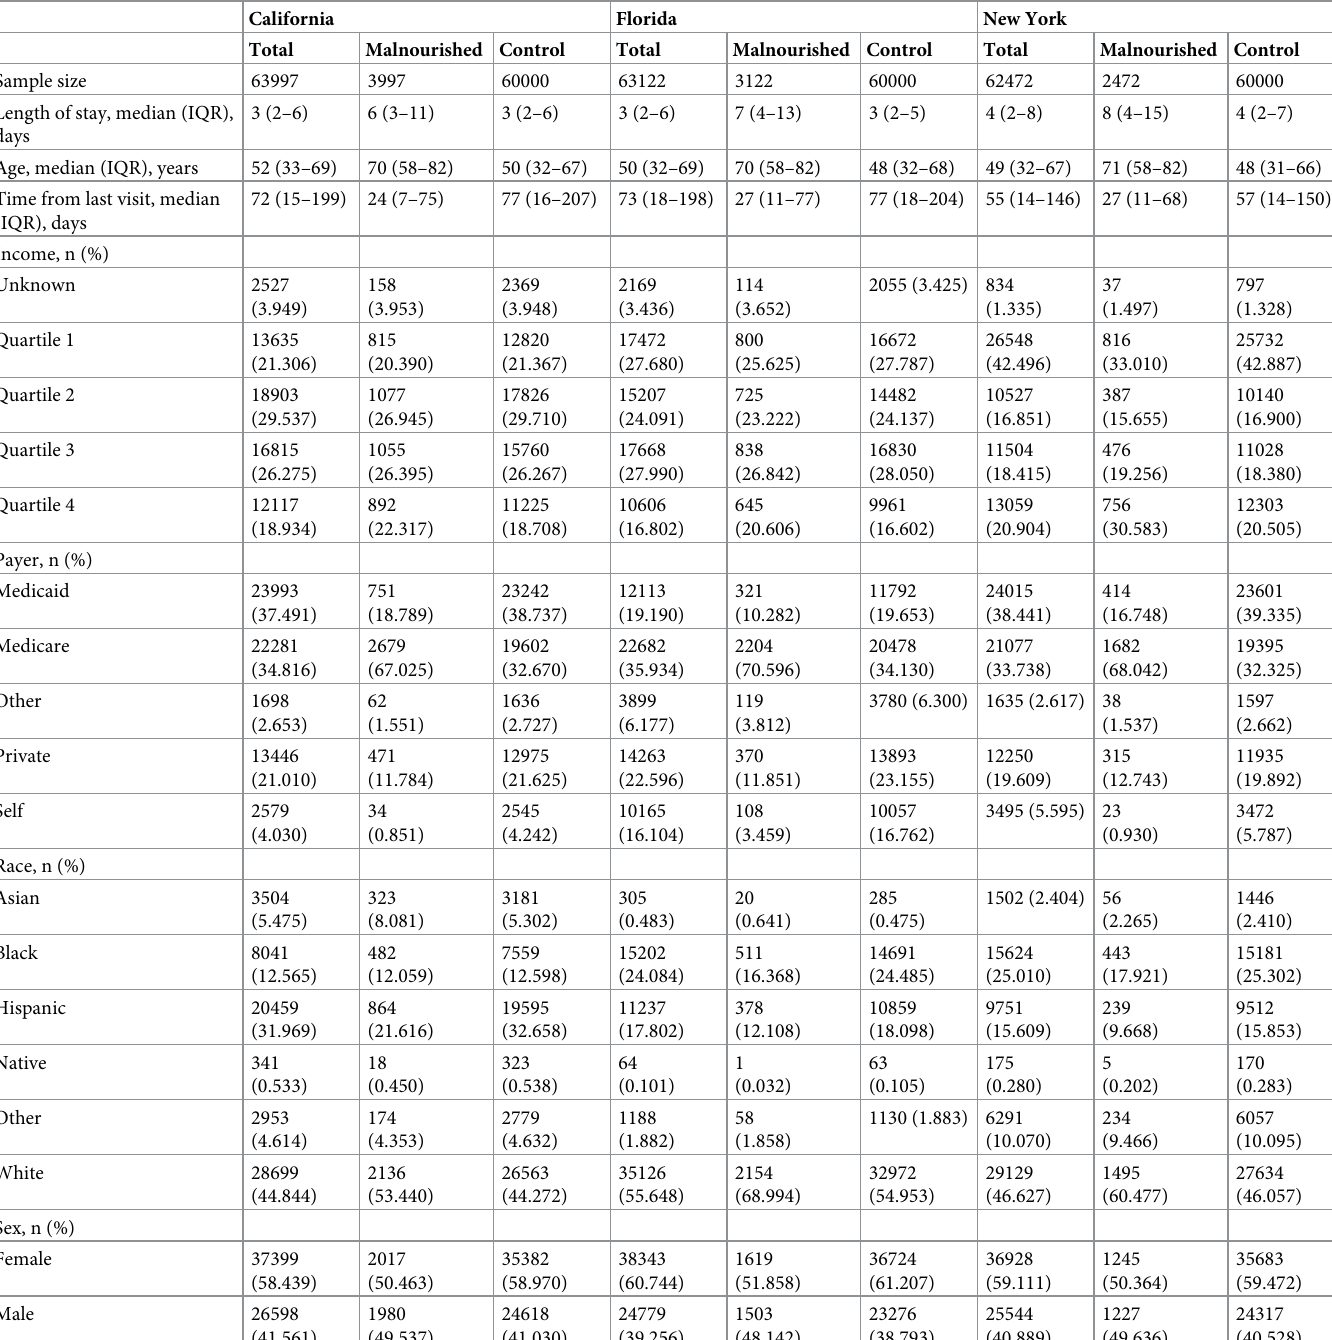
Table 1. Patient characteristics in test sets used to assess predictive